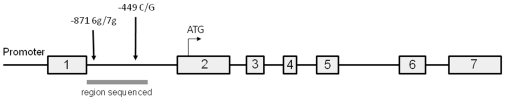

DDAH2 gene.Schematic representation of DDAH2 gene (adopted from www.ncbi.nlm.nih.gov/gene/23564), including the upstream promoter, the ATG translation start site, and the −871 6g/7g and −449 G/C polymorphisms. Exons are numbered 1–7. Exon 1 is non-coding, but this area and intron 1 appear to contain a second promoter region.